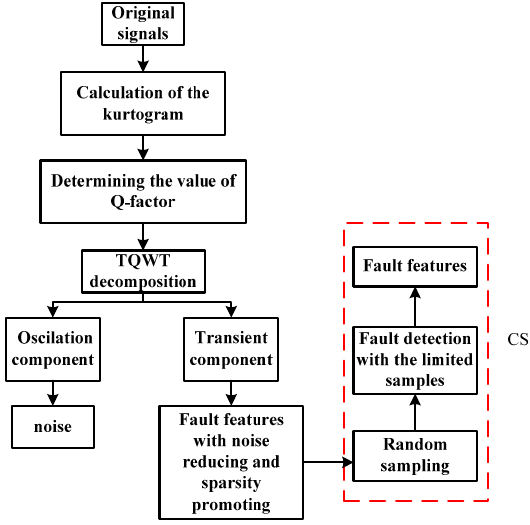
Sensors 2016 , 16 , 1524 Figure 4. The proposed fault detection method based on TQWT and CS. Figure 4. The proposed fault detection method based on TQWT and CS.